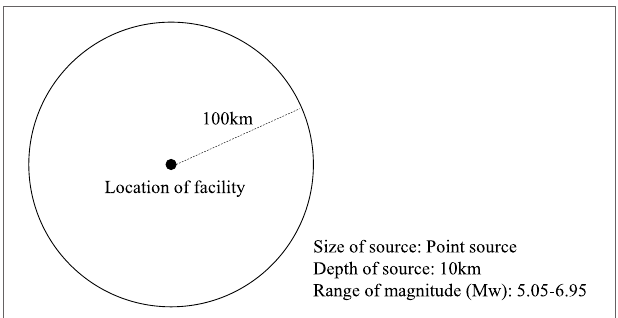
FIGURE 3 | Location of facility and the assumed area source . Size of source: point source; depth of source: 10km; range of magnitude ( M w ):